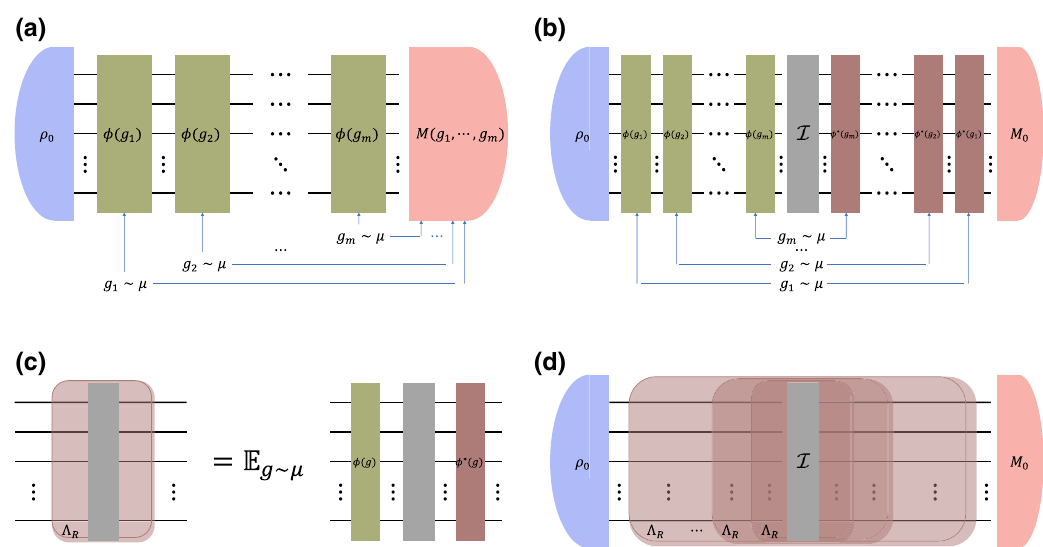
FIG. 1. A visual illustration of the URB framework and the twirling schemes. (a) A generic URB scheme. Given a sequence length m , we randomly select m IID samples from a distribution μ . The experiment then applies g 1 , . . . , g m sequentially via an implementation map φ on a fixed initial state ρ 0 , followed by a postprocessing POVM M that depends on the random elements g 1 , . . . , g m . (b) Approximate factoring. When the postprocessing POVM admits an approximate factoring, it can be approximately decomposed into an intermediate channel I , a sequence of inverting operations φ ∗ ( g m ) , . . . , φ ∗ ( g 1 ) , and a fixed measurement operator M 0 . (c) A